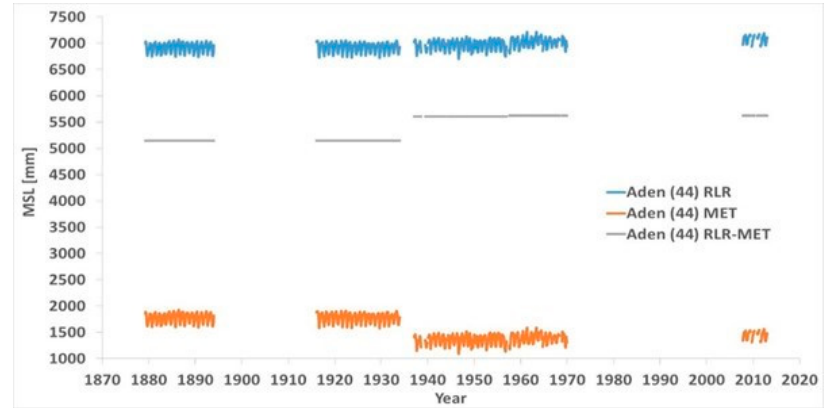
Figure 4. PSMSL RLR (revised local reference) and MET (metric) data for Aden, plus their difference Delta RLR-Met. There were five segments, with four offsets to verify.